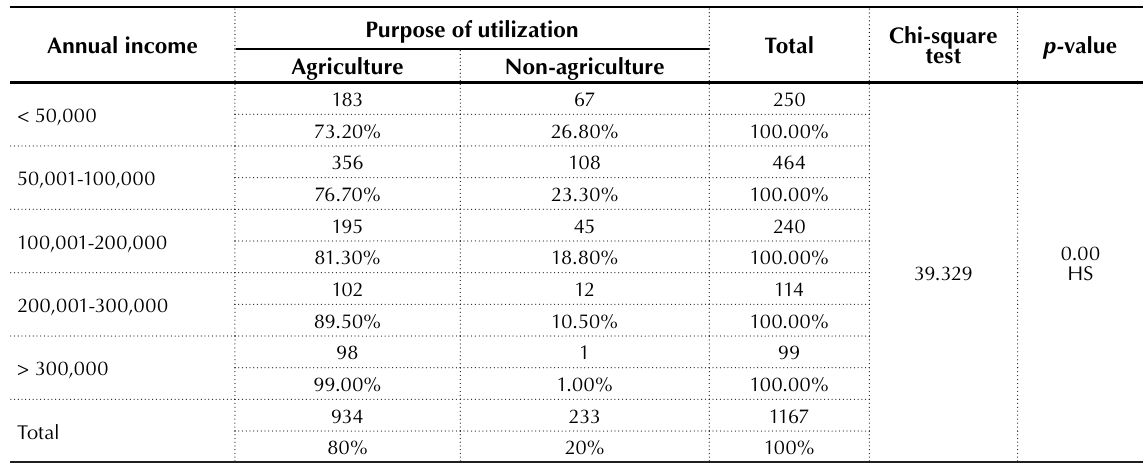
Source: Primary data.